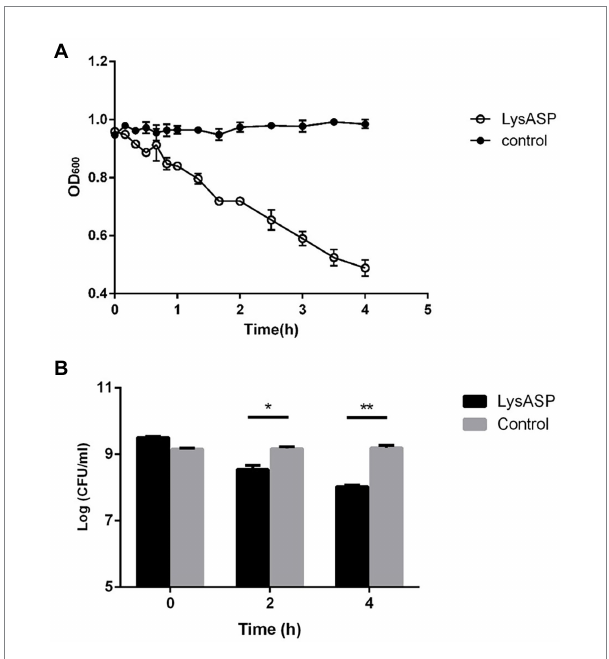
FIGURE 5 Lytic activity of purified LysASP against P. aeruginosa L64. (A) Changes in OD 600 of bacterial culture following LysASP treatment, (B) Bacterial counts at different time points following LysASP treatment. Data are expressed as mean ± SD ( n = 3). * p < 0.05, ** p <